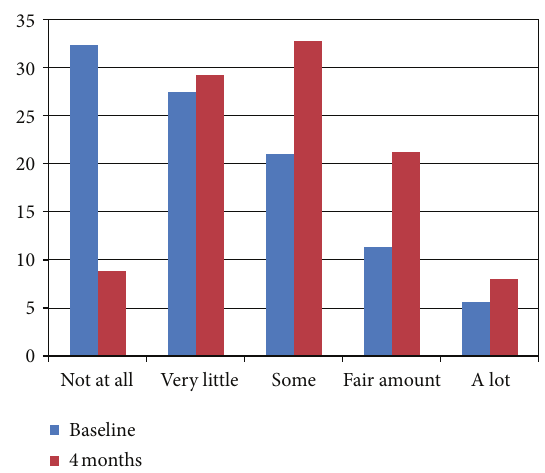
Figure 2: Frequency of response to how often the internet is used to get information on sleep apnea, at both baseline and four months (intervention group,